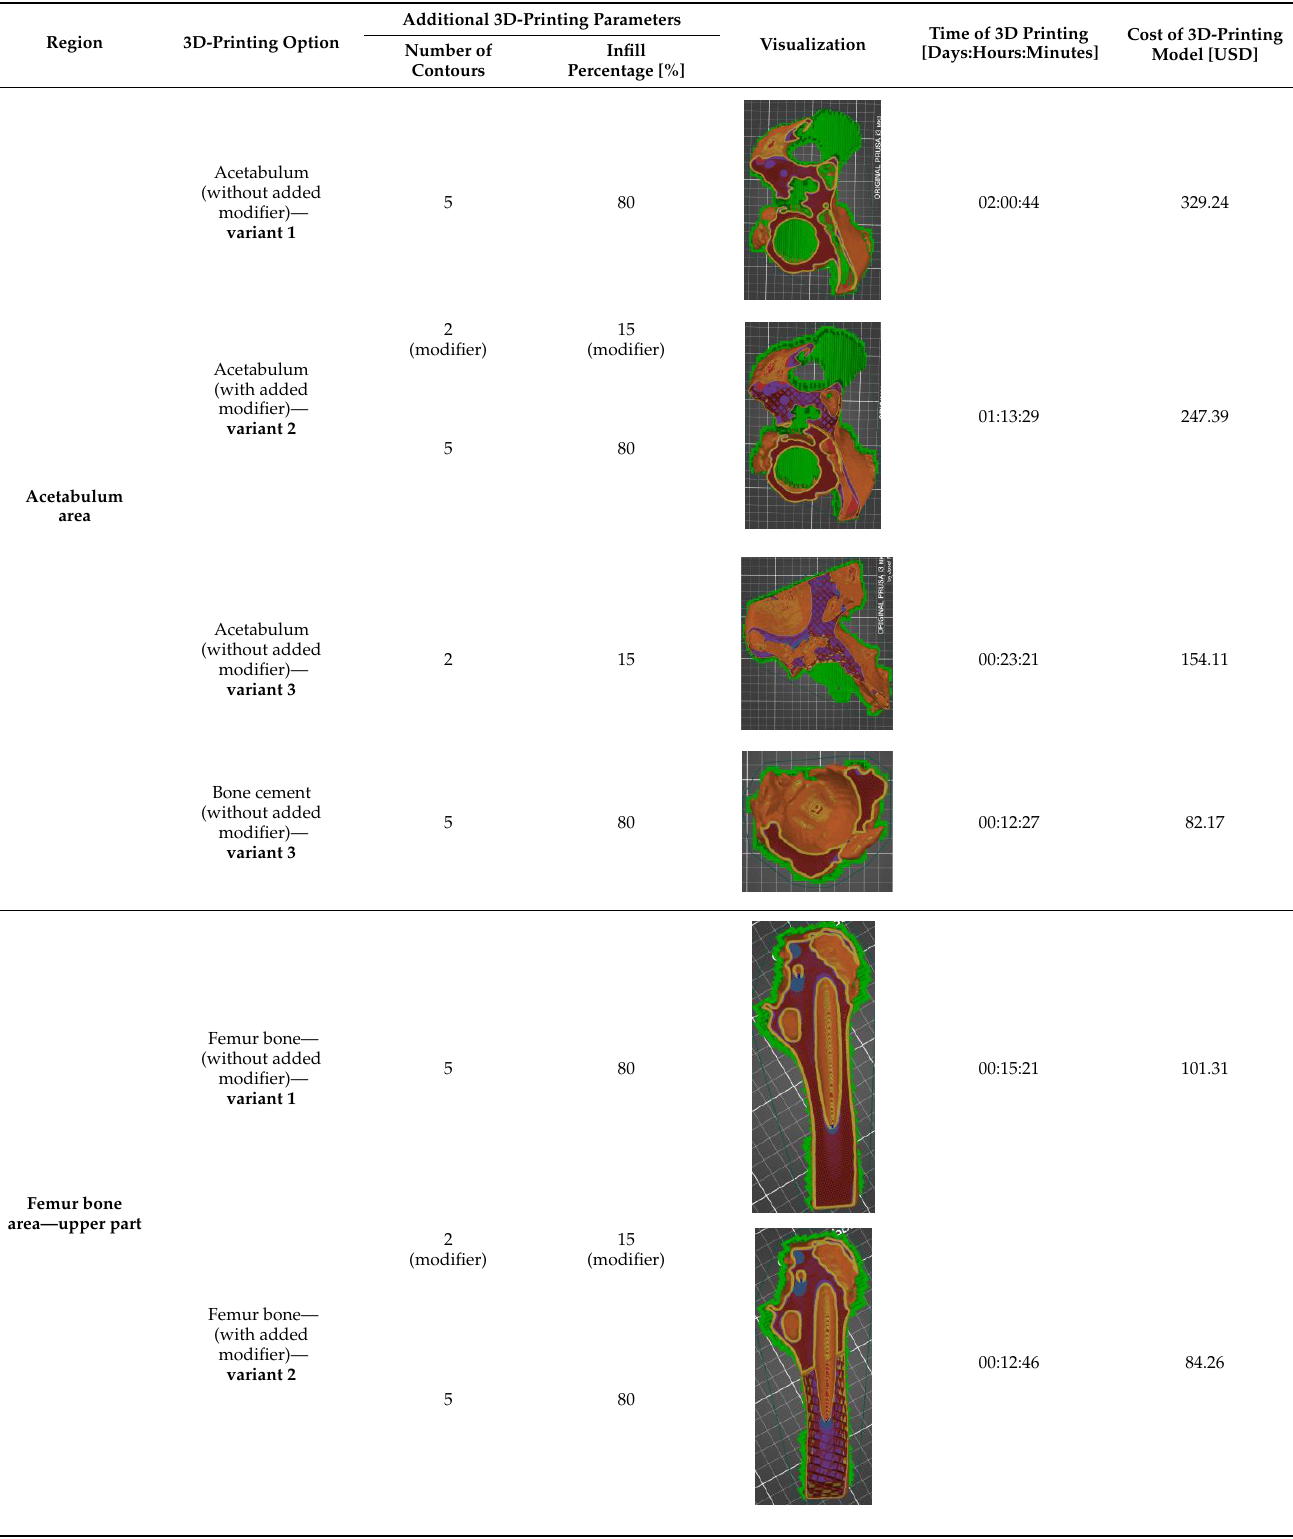
Table 9. Additional parameters and estimation of costs and time for 3D printing.